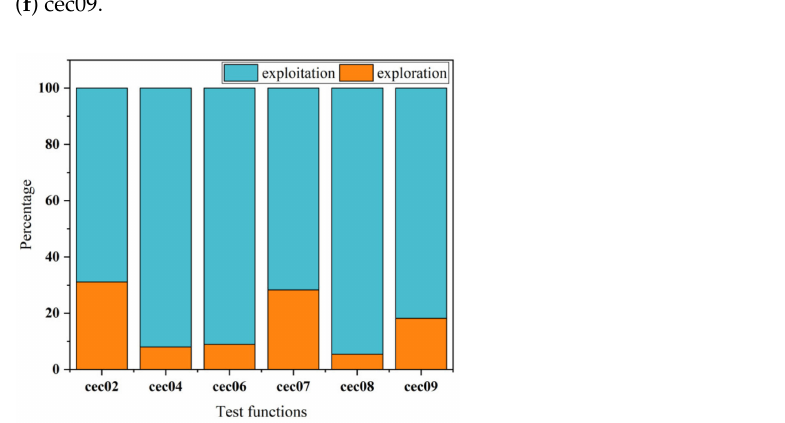
Figure 3. The exploration and exploitation behavior: ( a ) cec02; ( b ) cec04; ( c ) cec06; ( d ) cec07; ( e ) cec08;